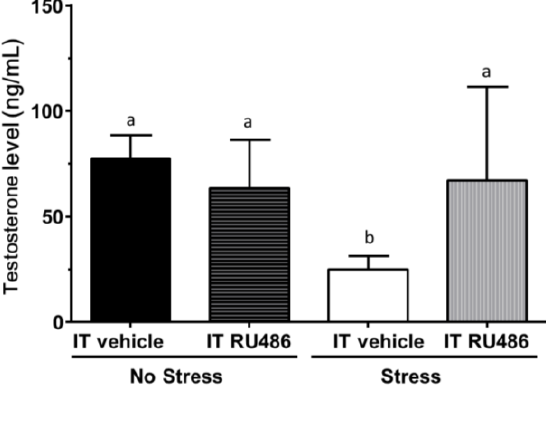
Figure 7. Interstitial fluid testosterone levels. Rats were assigned to no stress/intratesticular (IT) injection of vehicle (no stress/IT vehicle), no stress/intratesticular injection of RU486 (no stress/IT RU486), immobilization stress/Intratesticular injection of vehicle (stress/IT vehicle) and immobilization stress injected with RU486 (stress/IT RU486) groups. Mean ± SEM ( n = 6). Identical letters indicate no significant difference between two groups at p <